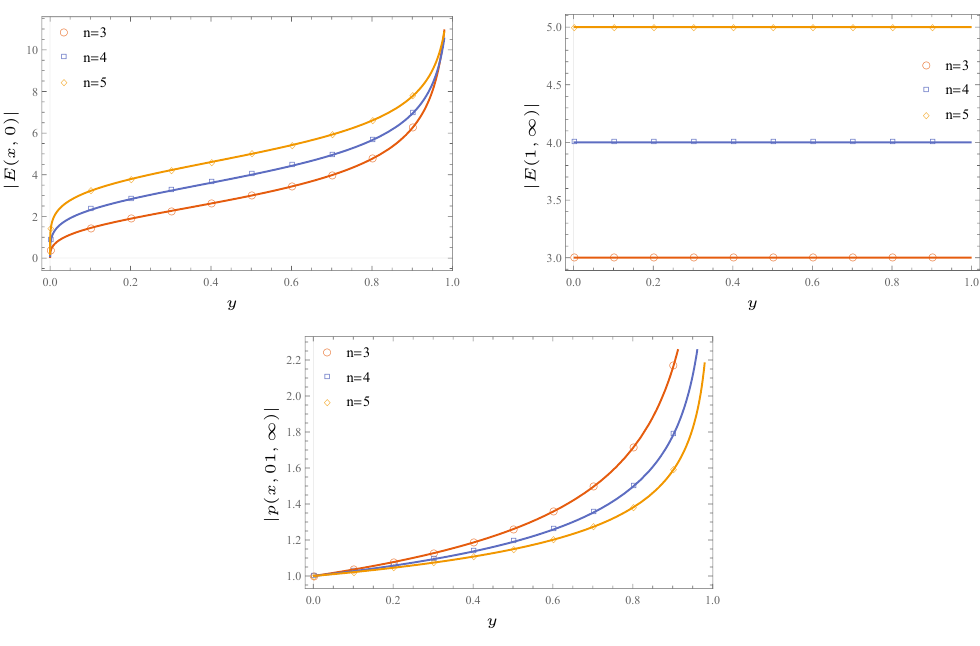
Figure 9 . Plots for the conjectures in eq. (4.22), eq. (4.23), and eq. (4.24). Horizontal axis is y = x . For vertical axis the solid lines are conjectured functions and the plotted points are x − 1 numerically computed values of modified prime forms and cross ratio